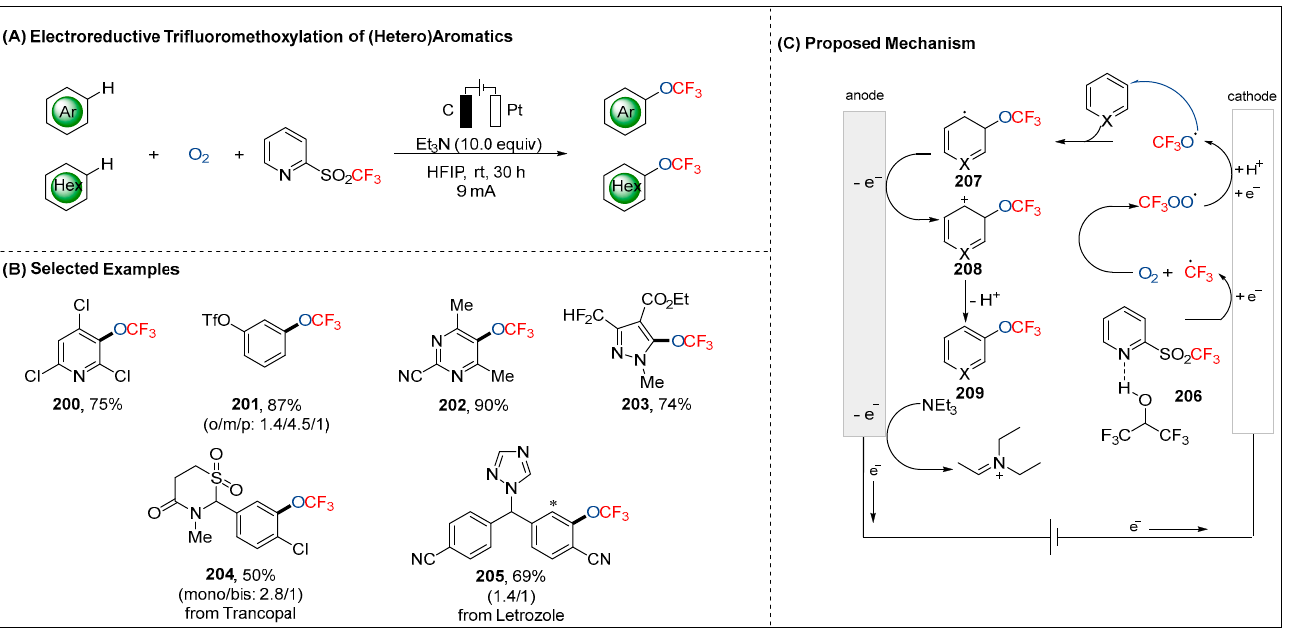
Figure 23. Electroreductive trifluoromethoxylation of (hetero)aromatics with a trifluoromethyl source and oxygen by Qing group.